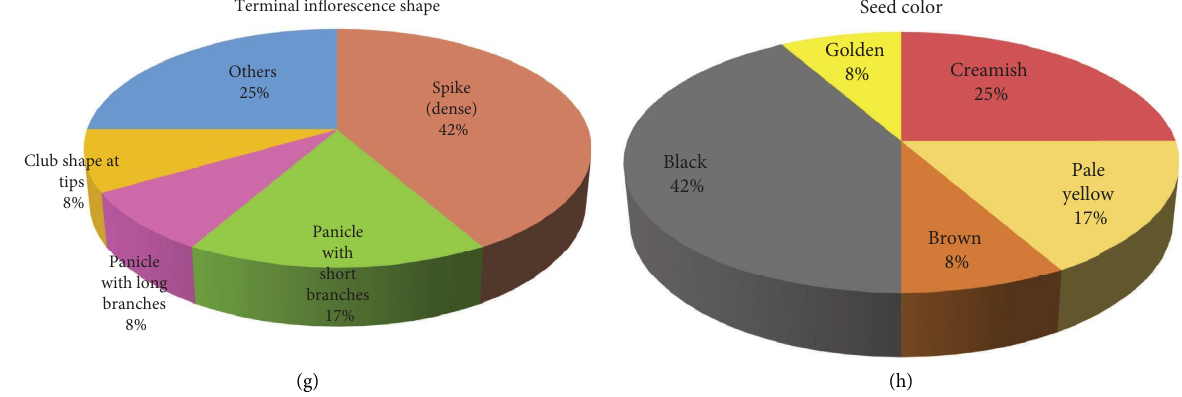
Figure 1: Frequency distribution of twelve amaranth accessions for (a) branching index, (b) stem pigmentation, (c) leaf margin, (d) leaf shape, (e) leaf pigmentation, (f) inforescence color, (g) terminal inforescence shape, and (h) seed color. Table 5: Diversity indices of 21 qualitative traits in amaranth.